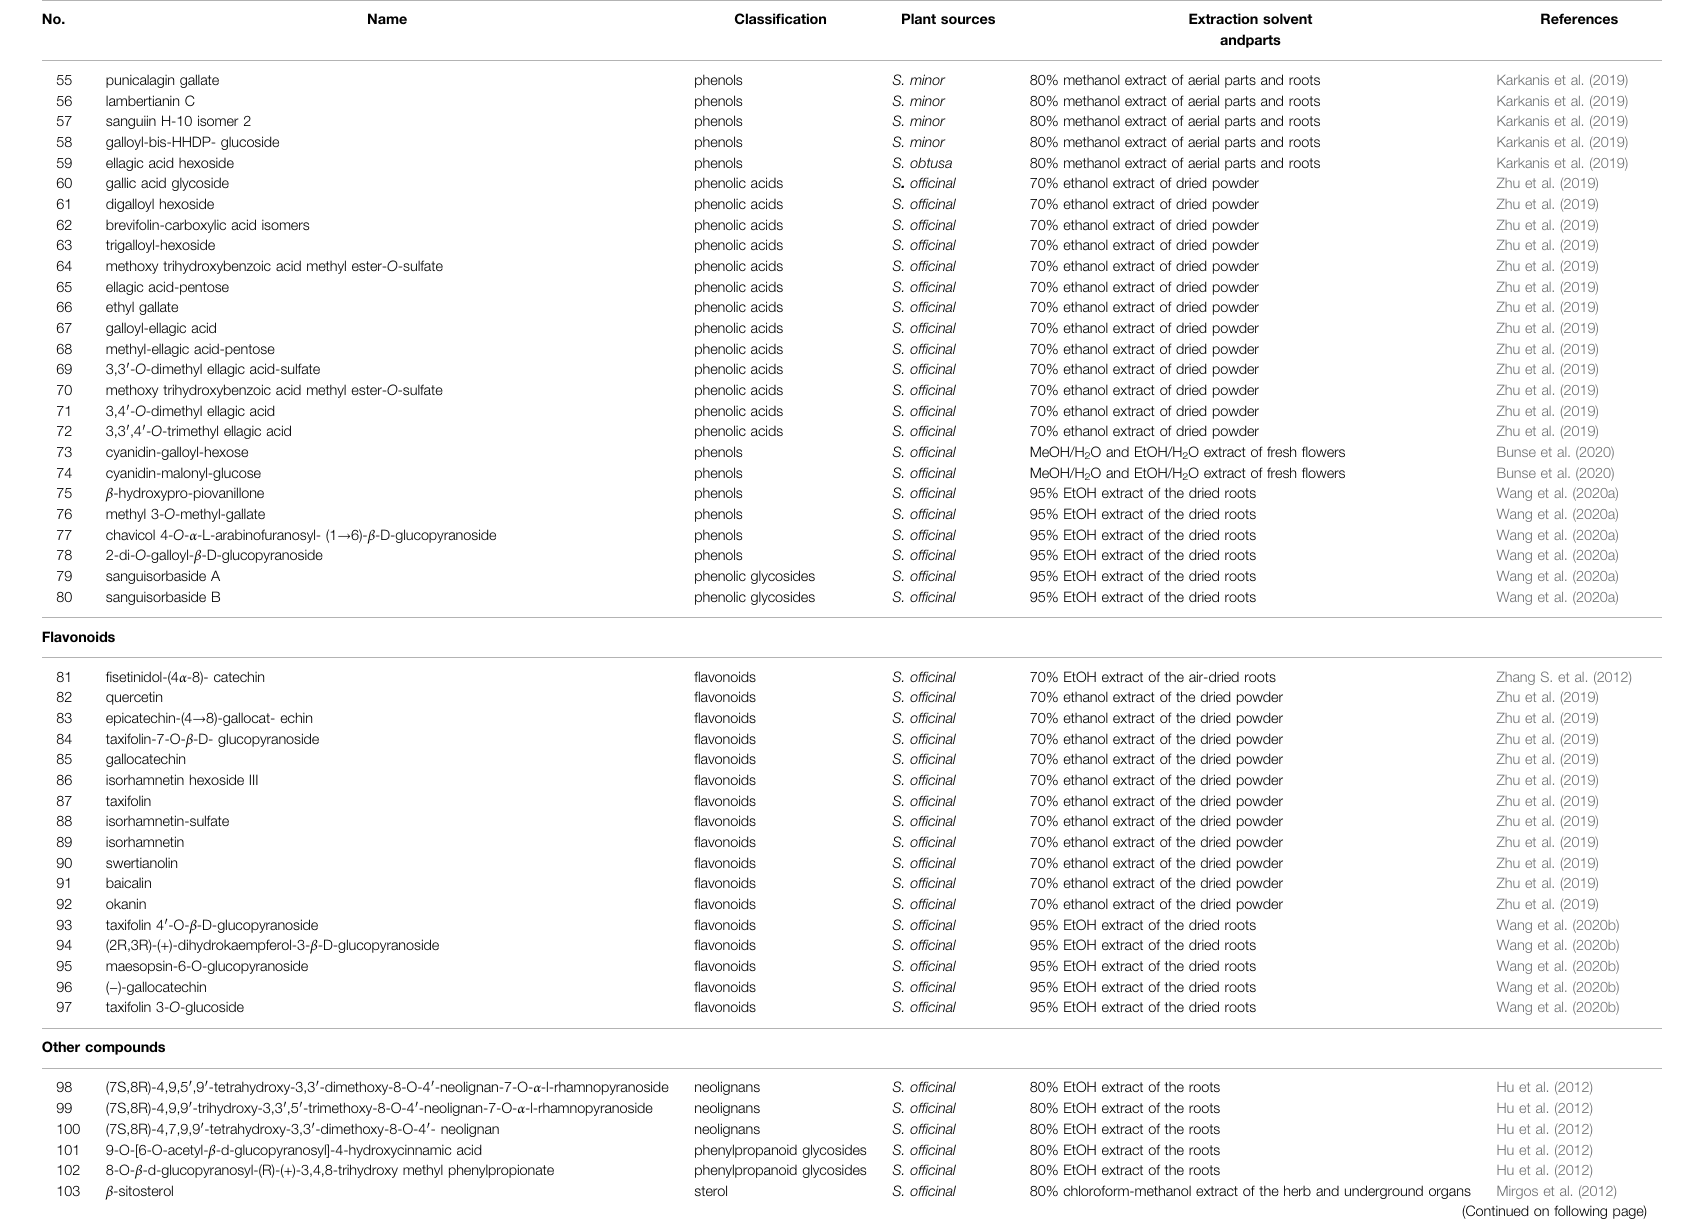
fl avonoids S. of fi cinal